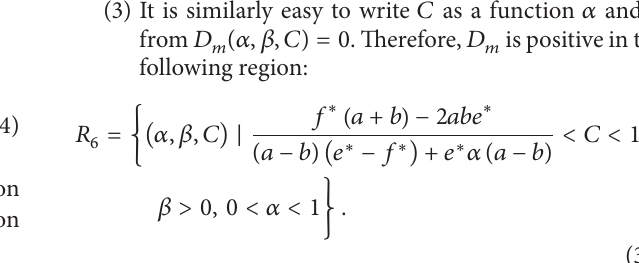
Region 𝑅 5 can now be rewritten